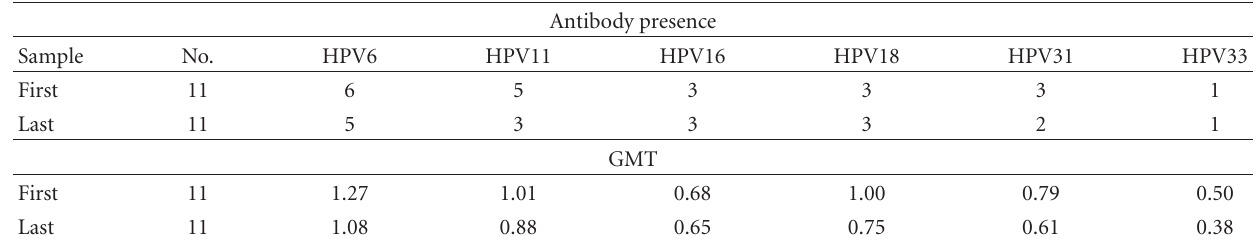
Table 8: Presence and geometric mean titres of antibodies against human papillomaviruses in CML patients prior to the start of the therapy and after achieving hematological and/or complete cytogenetic